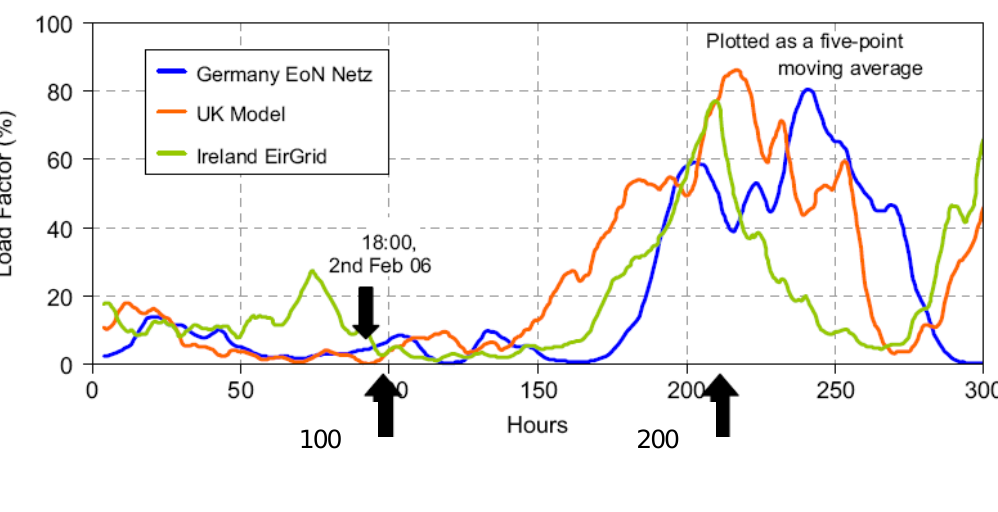
Figure 46. Variability and correlation of wind loads across Ireland, the UK and Germany. On 2 February 2006 the electricity demand in Britain reached its peak for 2006. © 2008 Elsevier, reproduced with permission from